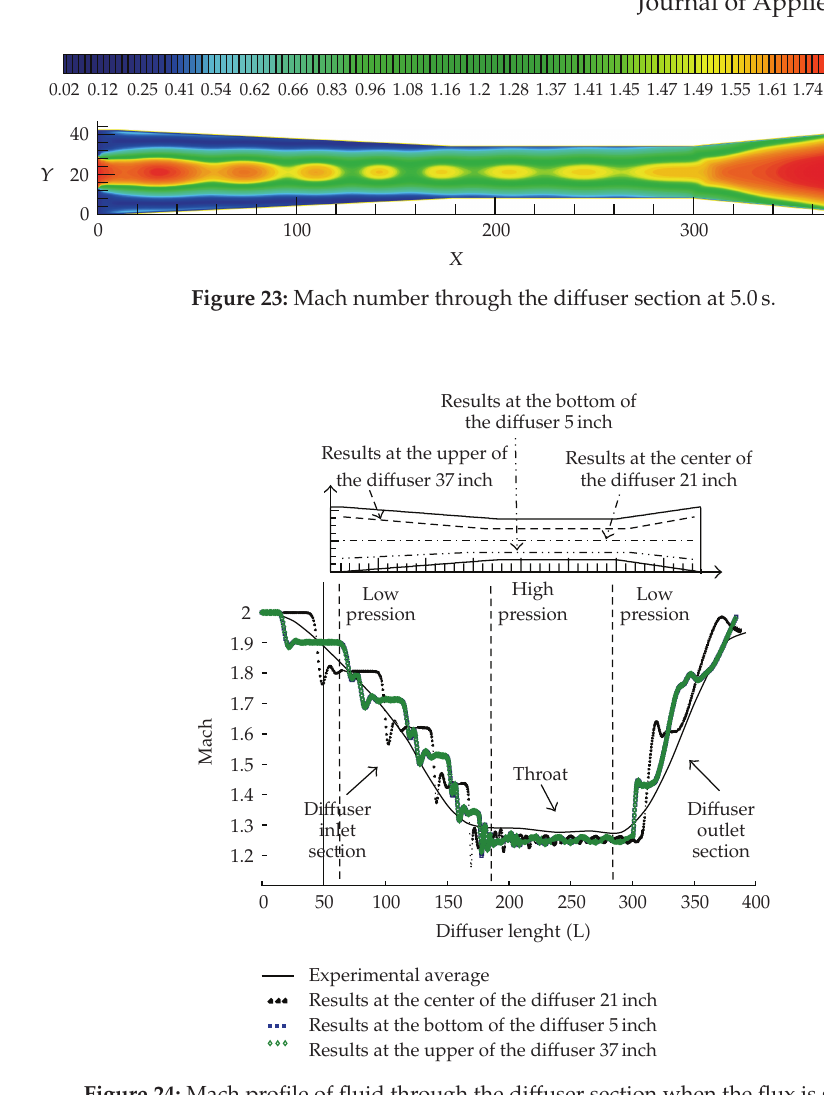
Figure 24: Mach profile of fluid through the di ff user section when the flux is